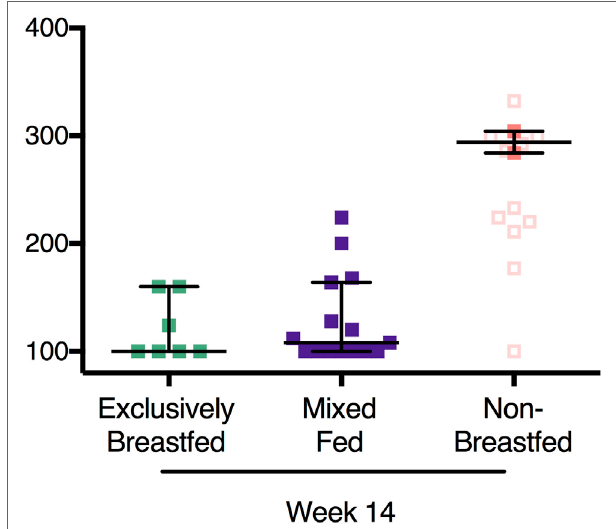
FigUre 3 | Recapitulation of ochratoxin A (OTA) exposure levels in HIV-exposed and -unexposed infants without elevation in OTA plasma levels in mixed fed infants. In filled colored squares: OTA plasma levels in HIV-unexposed infants that were exclusively breastfed, mixed fed, and non-breastfed infants at 14 weeks of age. In addition, plasma OTA levels from the non-breastfed, HIV-exposed infants at week 14 are also included (open squares). Bars reflect the median OTA plasma level for HIV-unexposed infants. p -Values reflect both HIV-exposed and HIV-unexposed infants.